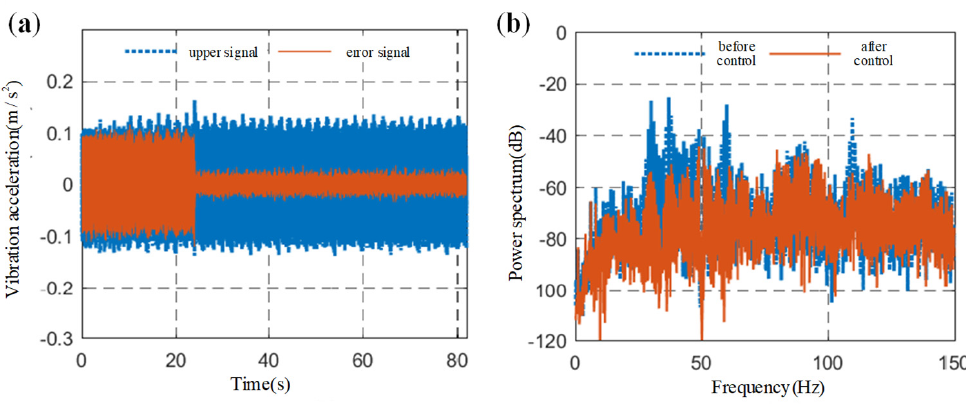
Figure 13. The test results of multi ‐ frequency line spectrum excitation active control (control scheme 1): ( a ) time history diagram; ( b ) power spectrum of error signal.